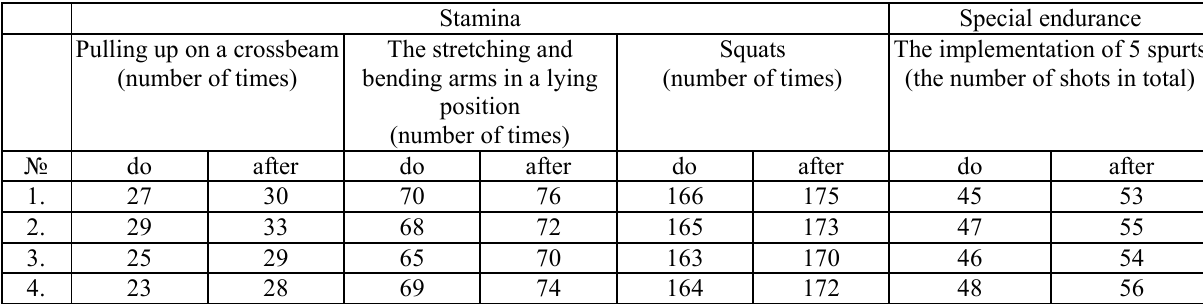
Evaluation of General and special endurance in the experimental